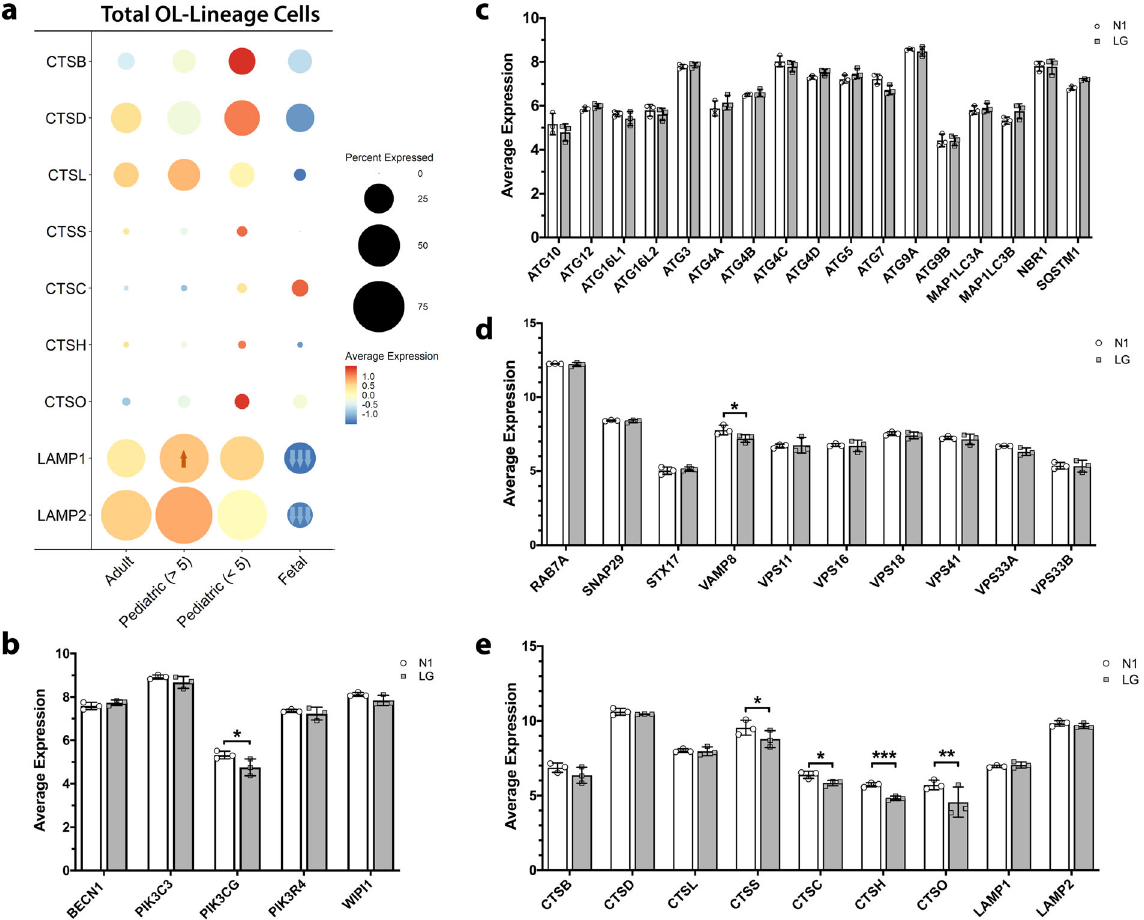
Fig. 5 Differential baseline expression of genes of the autophagy pathway in adult, pediatric, and fetal OL-lineage cells. a Relative expression of lysosome formation genes of the autophagy pathway in total OL lineage cells from adult, pediatric, and fetal samples. Scale is z-scores of averaged normalized gene expression across the age groups; percent expressed indicates the percentage of OL lineage cells in the age group expressing the gene. Arrows indicate up- (orange) or down- (blue) regulation (adj. p <0.05) against all other groups where one arrow is |logFC|>0.1, two arrows |logFC|>0.25, three arrows |logFC|>0.99, by Wilcoxon rank sum differential expression testing with Bonferroni correction. Number of independent biological samples by age group: 4 adult, 7 pediatric and 4 fetal. b – e Relative expression of genes involved in nucleation of autophagosomes ( b ), elongation of autophagosomes ( c ), fusion of autophagosomes and lysosomes ( d ) and lysosome formation ( e ) in optimal conditions (N1) and low glucose (LG) in adult OLs. mRNA expression was measured by microarray analysis with N = 3 independent biological samples from adult donors. Mean±SEM for each condition in the fi gure. Statistical signi fi cance was veri fi ed by Student ’ s t -test: *(<0.05), **(<0.01), ***(<0.001). SQSTM1 encodes for p62 and MAP1LC3B encodes for